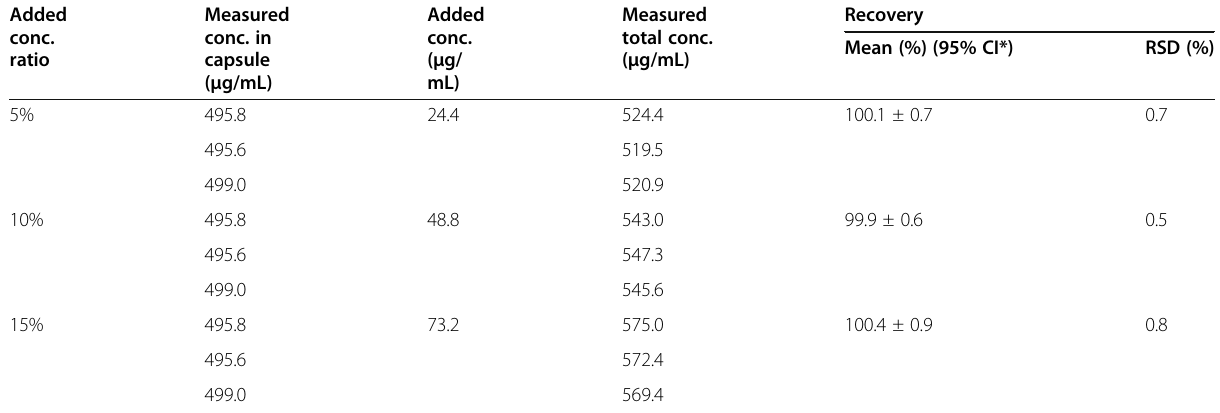
Table 1 Accuracy determination by method validation ( n = 3) Added conc.